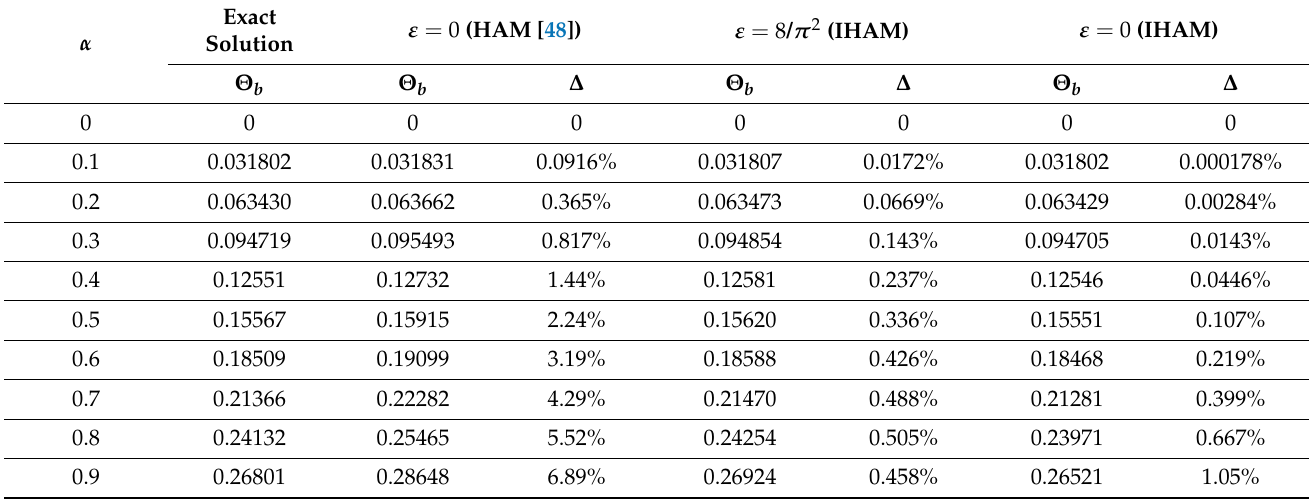
[ n = 1 ] by IHAM vs. exact solutions Θ b b